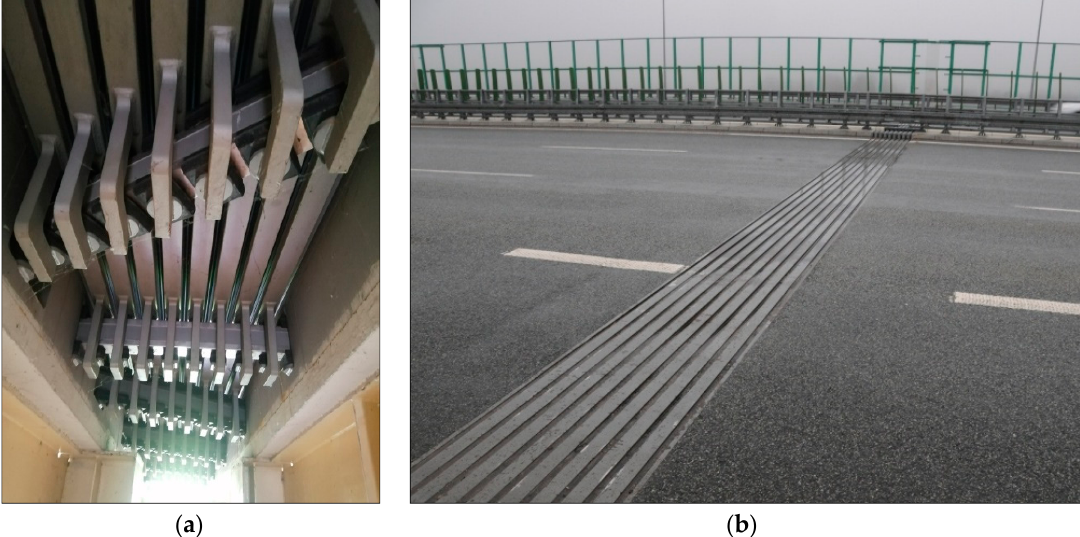
Figure 1. The modular expansion joints applied in the bridge: ( a ) view of the tested expansion joint from the bottom of the object; ( b ) view of the tested expansion joint from the road surface side.